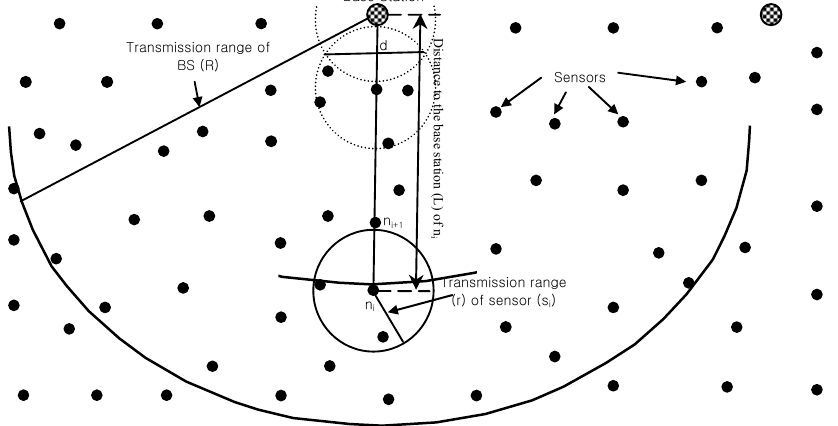
Figure 2. Forwarding area of a sensor in sensor networks, stuck node and